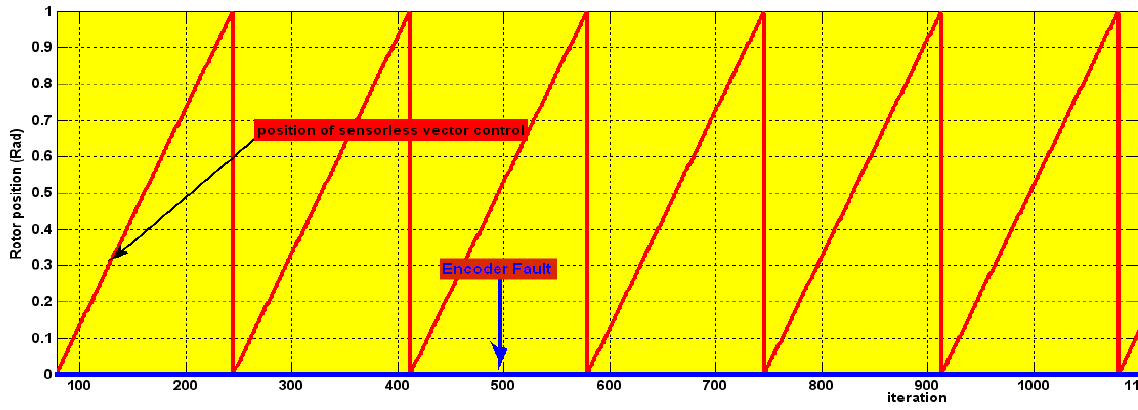
Figure 23. Experimental rotor position: Complete sensor